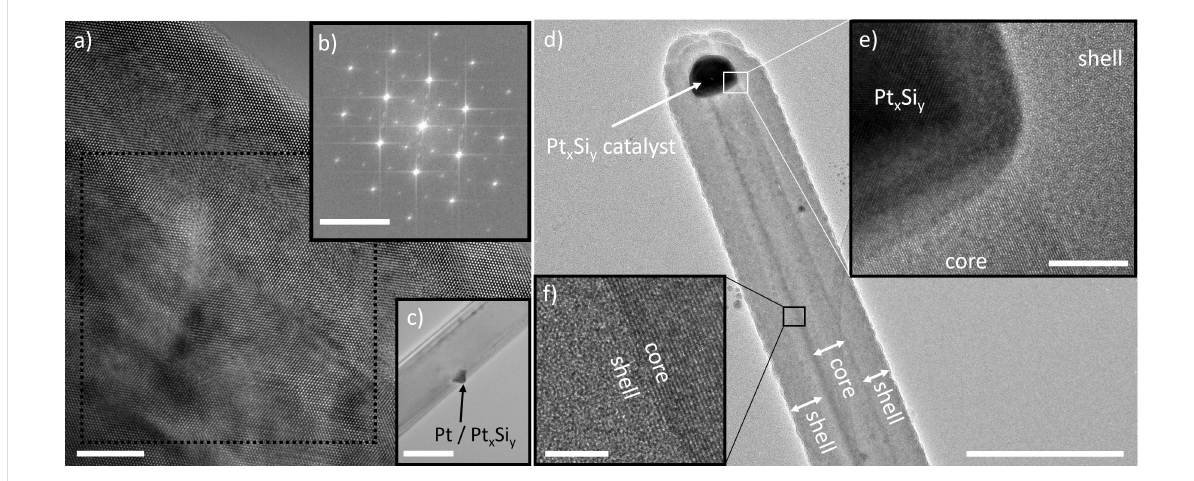
Figure 1: a) High-resolution TEM image of a segment of a SiNW obtained through Pt-catalyzed growth that exhibits several defects and differently oriented crystalline grains. b) The fast Fourier transformation image of the indicated area in panel a. c) TEM image showing a migrated metal particle on a SiNW. d) TEM image of a Pt-catalyzed core–shell SiNW showing the morphology of the junction between SiNW core and shell. e) Pt silicide catalyst and the shell region. f) Illustration of the interface between the SiNW core and the shell. Scale bars are for a) 5 nm, b) 5 nm − 1 , c) 100 nm, d) 200 nm, e) 10 nm and f) 5